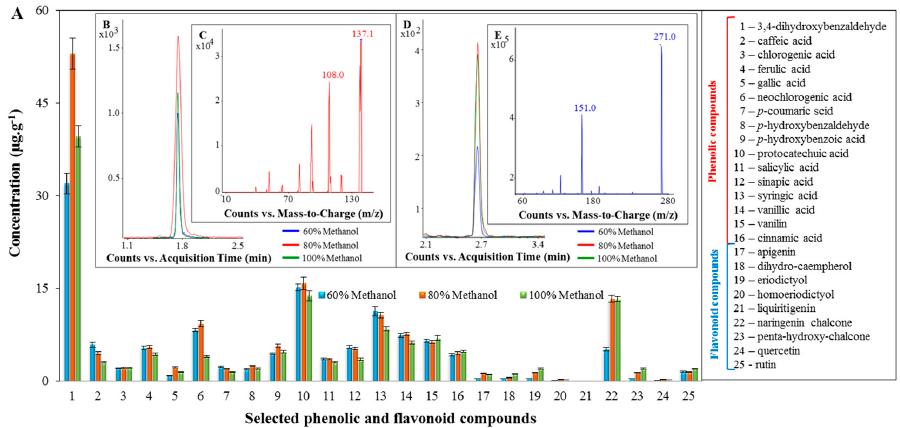
Figure 3. Extract from black pepper: ( A ) determination of concentration of selected phenolic and flavonoid compounds; ( B ) Multiple reaction monitoring (MRM) chromatograms of 3,4-dihydroxybenzaldehyde; ( C ) fragmentation spectrum for 3,4-dihydroxybenzaldehyde (108.0 is the product ion and 173.1 is the precursor ion); ( D ) Multiple reaction monitoring (MRM) chromatograms for naringenin chalcone; and ( E ) fragmentation spectrum for naringenin chalcone (151.0 is the product ion and 271.0 is the precursor ion).